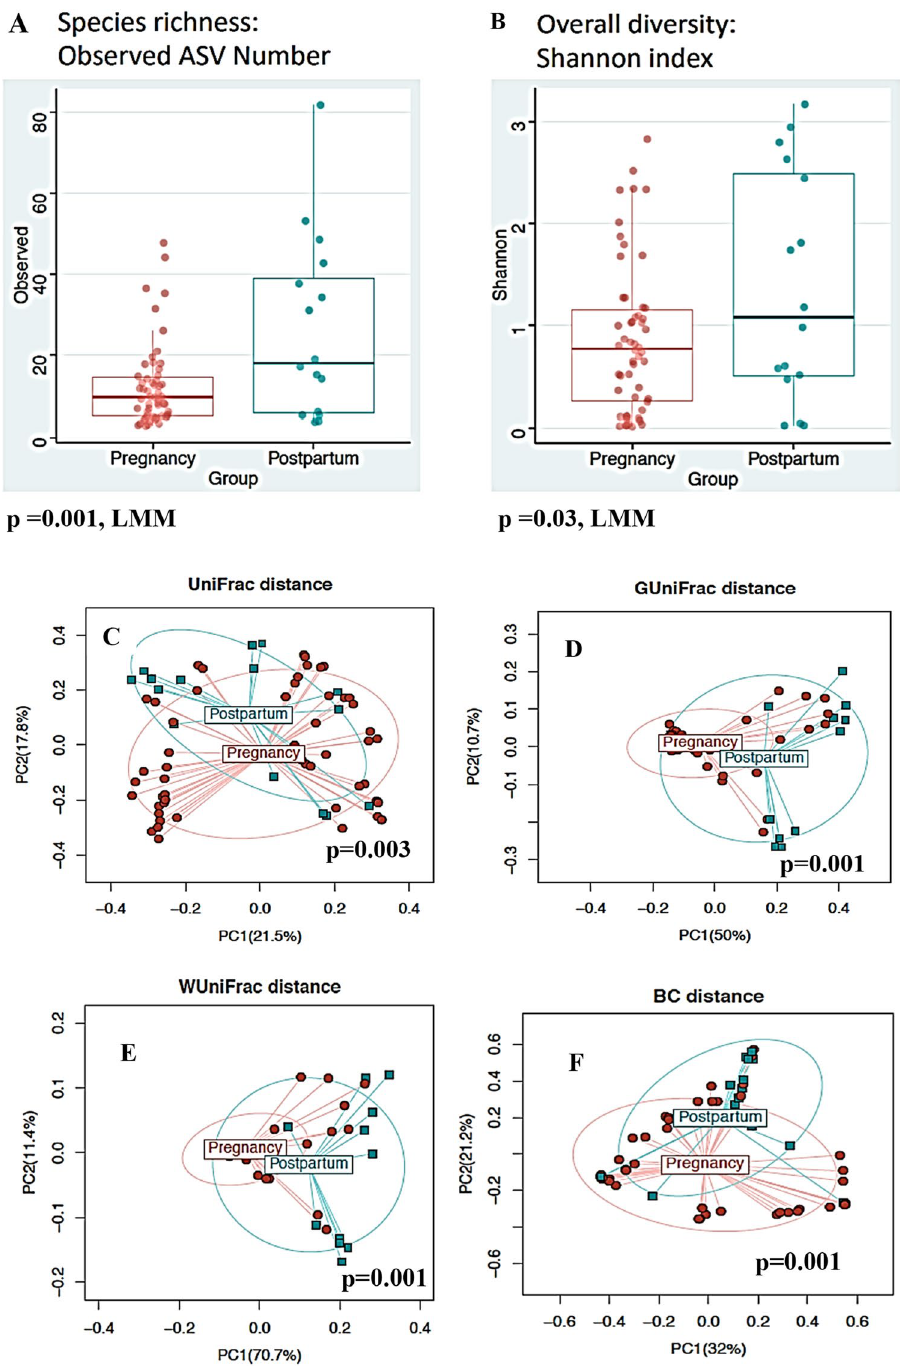
Figure 5. α- and β-diversity of vaginal microbiome of participants’ pregnancy and postpartum vaginal samples. (A) α-diversity computed with observed amplicon sequence variants (B) Shannon diversity index metrics. Participants group are identified with colored dots within bar boxes (light red-postpartum; pine green-term). Postpartum group shows higher diversity and greater number of amplicon sequence variants (ASV) compared to term group. β-diversity, based on (C) unweighted, (D) generalized, (E) weighted and (F) Bray Curtis UniFrac distance. Participants group are identified with color and shape within a circle (circular red, preterm birth squared pine green, term). A significant separation between the term and preterm birth microbiome community was observed (p unweighted = 0.003, p generalized = 0.001, p weighted = 0.001, p Bray Curtis = 0.001 respectively; Omnibus